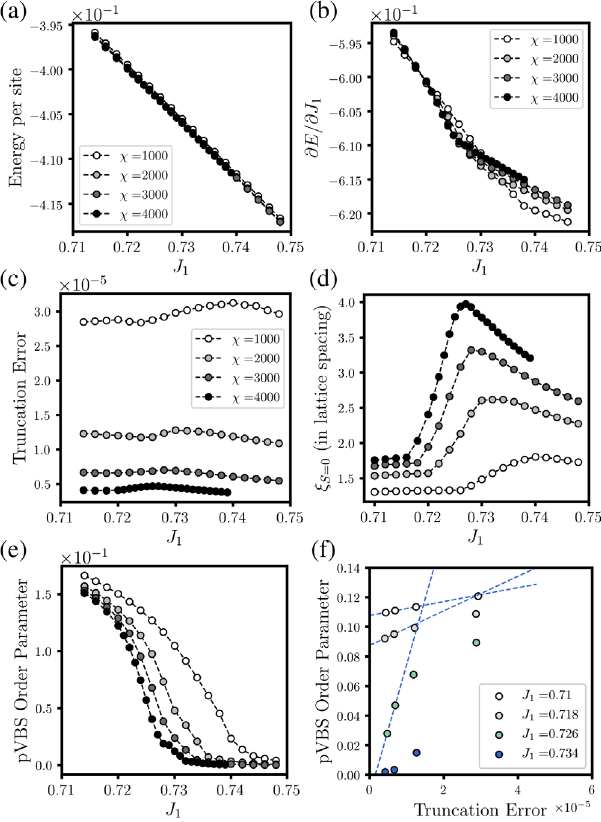
FIG. 17. The IDMRG simulation results with Δ J 1 ¼ 0 . 002 (0.001 for χ ¼ 4000 ) at L ¼ 8 , shown for a range of MPS bond dimension χ . Different observables are labeled as in Fig. 16. Here, again (c) – (e) share the same labels for different bond dimensions. Note that the PVBS order parameter vanishes at J 1 ¼ 0 . 726 , which is smaller than the value for L ¼ 10 .